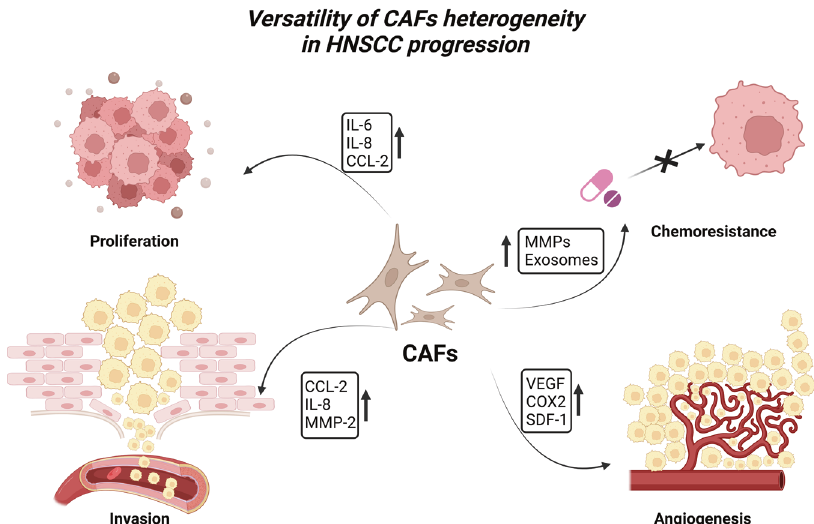
Fig. 2 Versatility of cancer-associated fi broblasts (CAFs) heterogeneity in HNSCC progression. By the synthesis of cytokines, chemokines, and the extracellular matrix (ECM) in the TME, CAFs perform a range of roles in carcinogenesis, including proliferation, chemoresistance, invasion, and angiogenesis. As epithelial cells undergo the transformation to become CAFs during the premalignant stage, it is believed that the primary function of CAFs in the development of cancer is to stimulate the proliferation of cancer cells. In the coculture of CAFs/NFs-OCCs, CAFs but not NFs facilitated OCC cell proliferation and invasion, and MMP-2 derived from senescent CAFs induced keratinocyte dis-cohesion and epithelial invasion into collagen gels in a TGF- β -dependent manner. In addition, CAFs can cause angiogenesis in HNSCC by producing PGE2 through COX-2, and VEGF and SDF-1 are required for CAFs to stimulate neoangiogenesis in the tissue of NPC. Moreover, by secreting exosomes to the tumor, CAFs can confer HNSCC therapy resistance, such as chemoresistance. (Created with